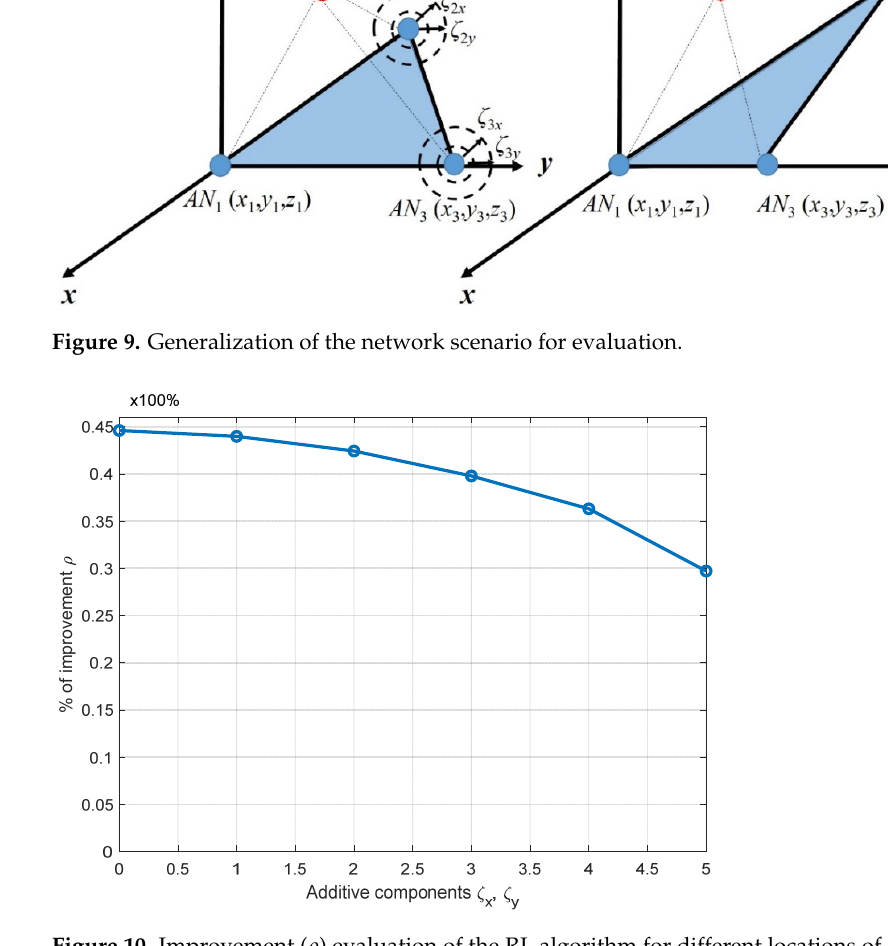
Figure 10. Improvement ( ρ ) evaluation of the RL algorithm for different locations of AN 2 and AN 3 .